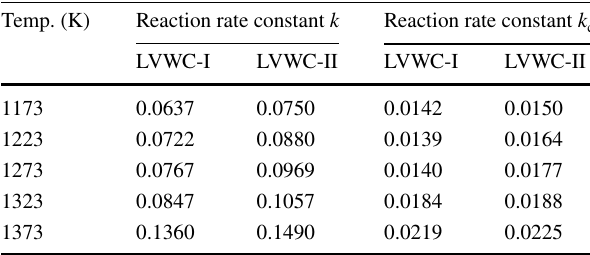
Fig. 4 Graph of − ln(1 − X ) versus residence time for LWVC-II